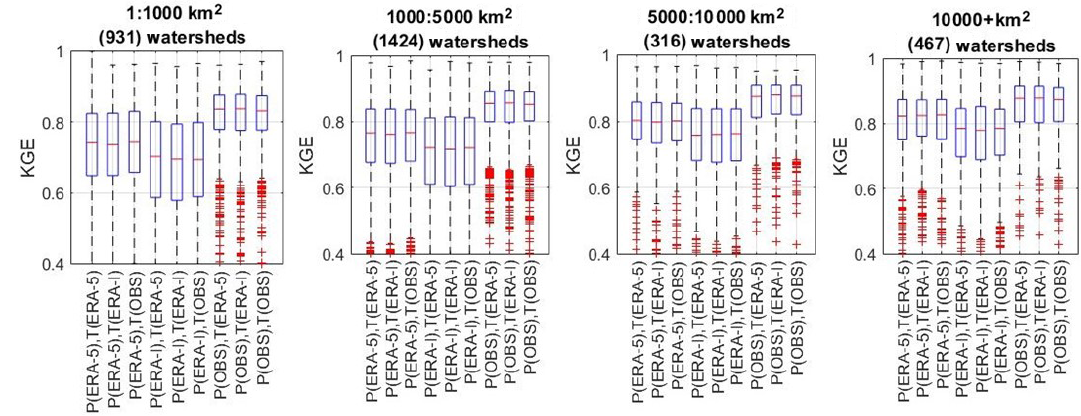
Figure 7. Distribution of the Kling–Gupta efficiency metrics for various watershed surface areas, for hydrological model HMETS.